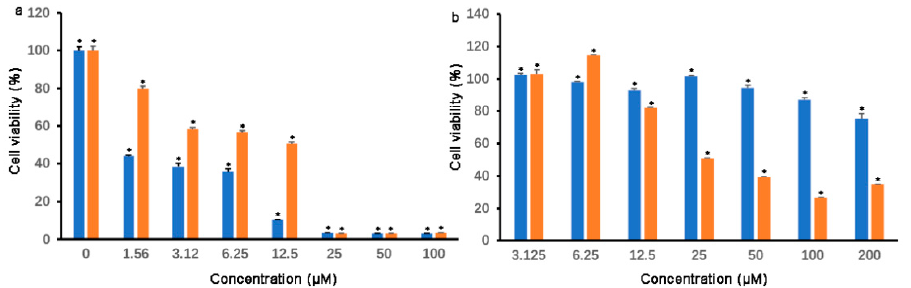
Figure 2. The cell viability of HCT116 ( a ) and normal LO2 ( b ) cells exposed to different concentra- tions of Ir1 (blue) and Ir2 (orange) for 48 h. * p < 0.05 represents significant difference compared with the control.